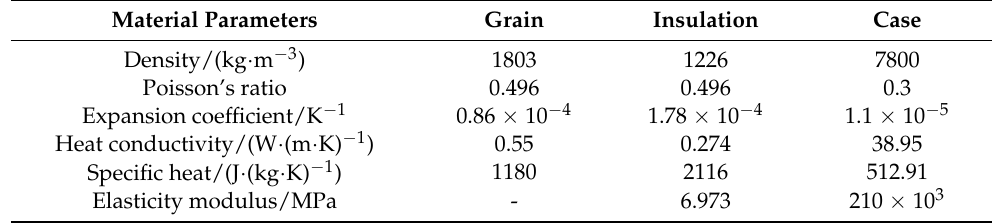
Table 2. Material properties parameters.